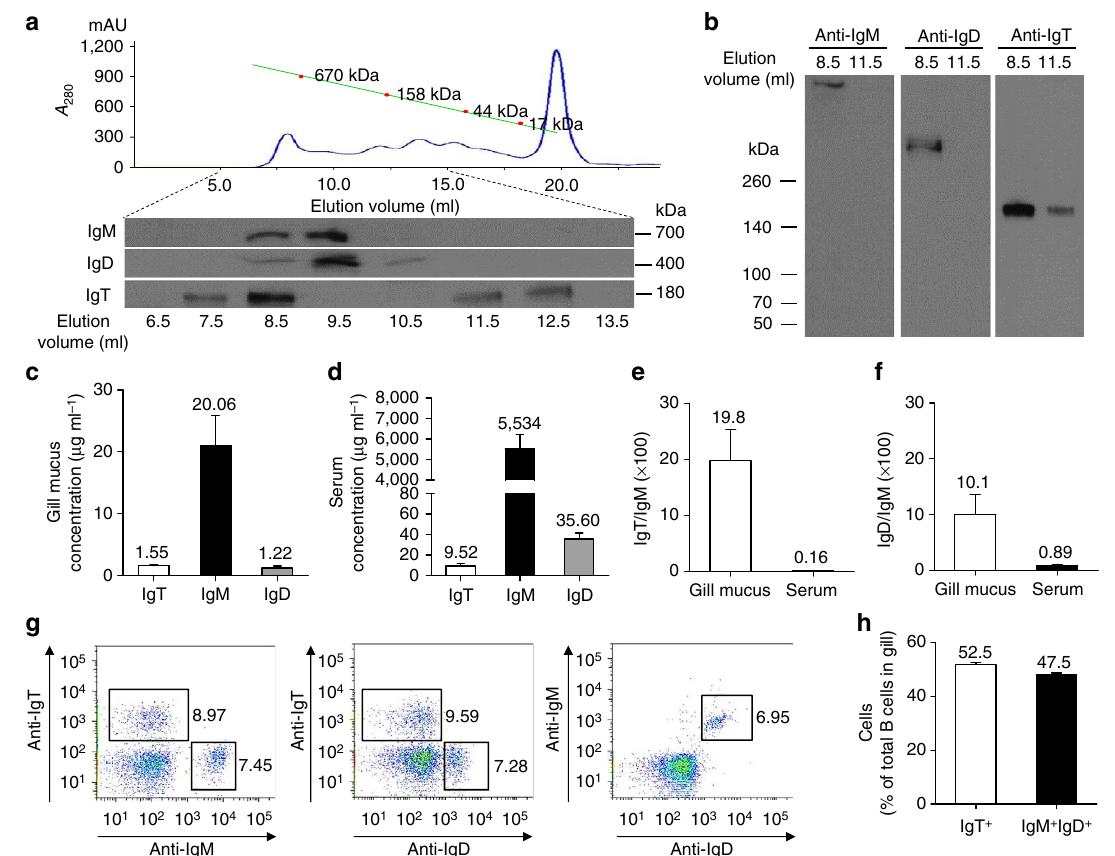
Figure 1 | Protein characterization of gill mucus immunoglobulins and identification of B cells in the gill of trout. ( a ) Fractionation of gill mucus ( B 0.5ml) by gel filtration (upper) followed by immunoblot analysis of the fractions with anti-trout IgM, anti-trout IgD and anti-trout IgT-specific mAbs (lower). A 280 , absorbance at 280nm. ( b ) SDS–PAGE of gel-filtration fractions (4–15%) corresponding to elution volumes of 8.5 and 11.5ml under non- reducing conditions followed by immunoblot analysis with mAbs to trout IgM, IgD or IgT. ( c , d ) Immunoblot and densitometric analysis of the concentration of IgT, IgM and IgD in gill mucus ( c ) and serum ( d ) ( n ¼ 15 fish). ( e , f ) Ratio of IgT to IgM concentration ( e ) and IgD to IgM concentration ( f ) in gill mucus and serum, calculated from the values shown in c , d . ( g ) Dot plots of leucocytes from gills. Numbers adjacent to outlined areas indicate percentage IgT þ B cells, IgM þ B cells or IgD þ B cells in the lymphocyte gate. ( h ) Frequency of IgT þ and IgM þ IgD þ B cells among total B cells. Results in c – e and h are expressed as mean and s.e.m. obtained from 15 individual